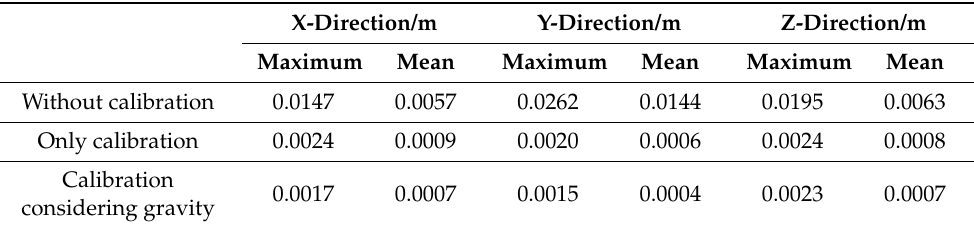
Table 4. MD-H parameters of the robot after identification combined with gravity compensation. Joint